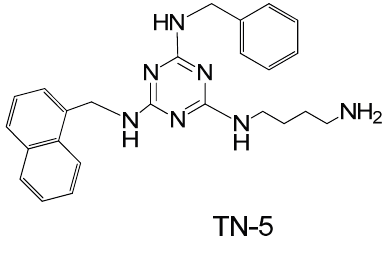
Figure 1. Chemical structure of